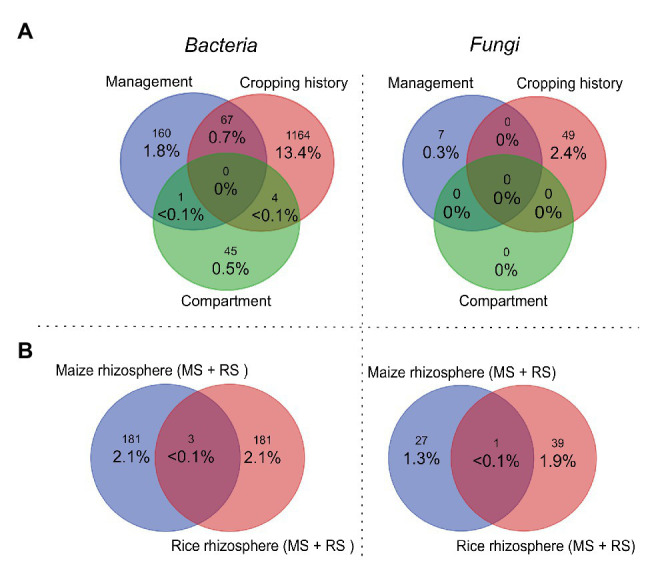
Venn diagrams displaying the percentages of bacterial (left) and fungal (right) OTUs and OTU numbers (small numbers) that were significantly affected in relative abundance in dependence on different grouping factors according to a STAMP analysis. (A) Displays the percentages and numbers of OTUs that were significantly affected by compartment, management (crop plant), and cropping history. Overlapping regions show numbers of those OTUs that were affected by two or even all three factors. Venn diagrams in (B) show percentages and numbers of OTUs that were significantly enriched in the rhizosphere vs. bulk soil comparatively for maize and rice. The rhizosphere-specific OTUs were identified for each plant independently in the two soils (MS and RS, considering only samples taken after 3 months) and then combined in one list per plant species to build the diagram. Percentages in all plots were calculated in relation to the total numbers of OTUs identified in this study (8,700 bacterial OTUs and 2,060 fungal OTUs). MS, maize soil; RS, rice soil.